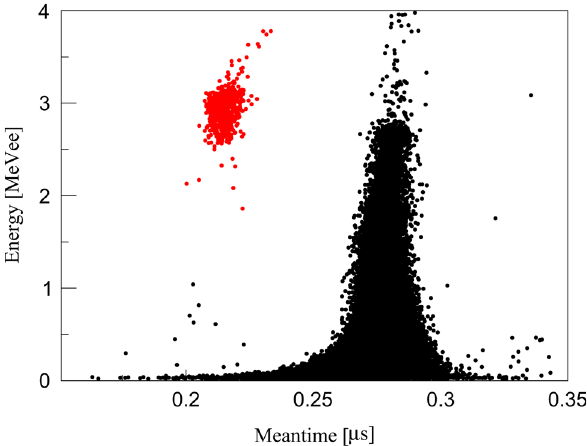
Fig. 10 Mean time versus energy of the NEO-6 crystal. The mean time parameter separates the α events from the β / γ events as indicated by the red dots in a short mean time